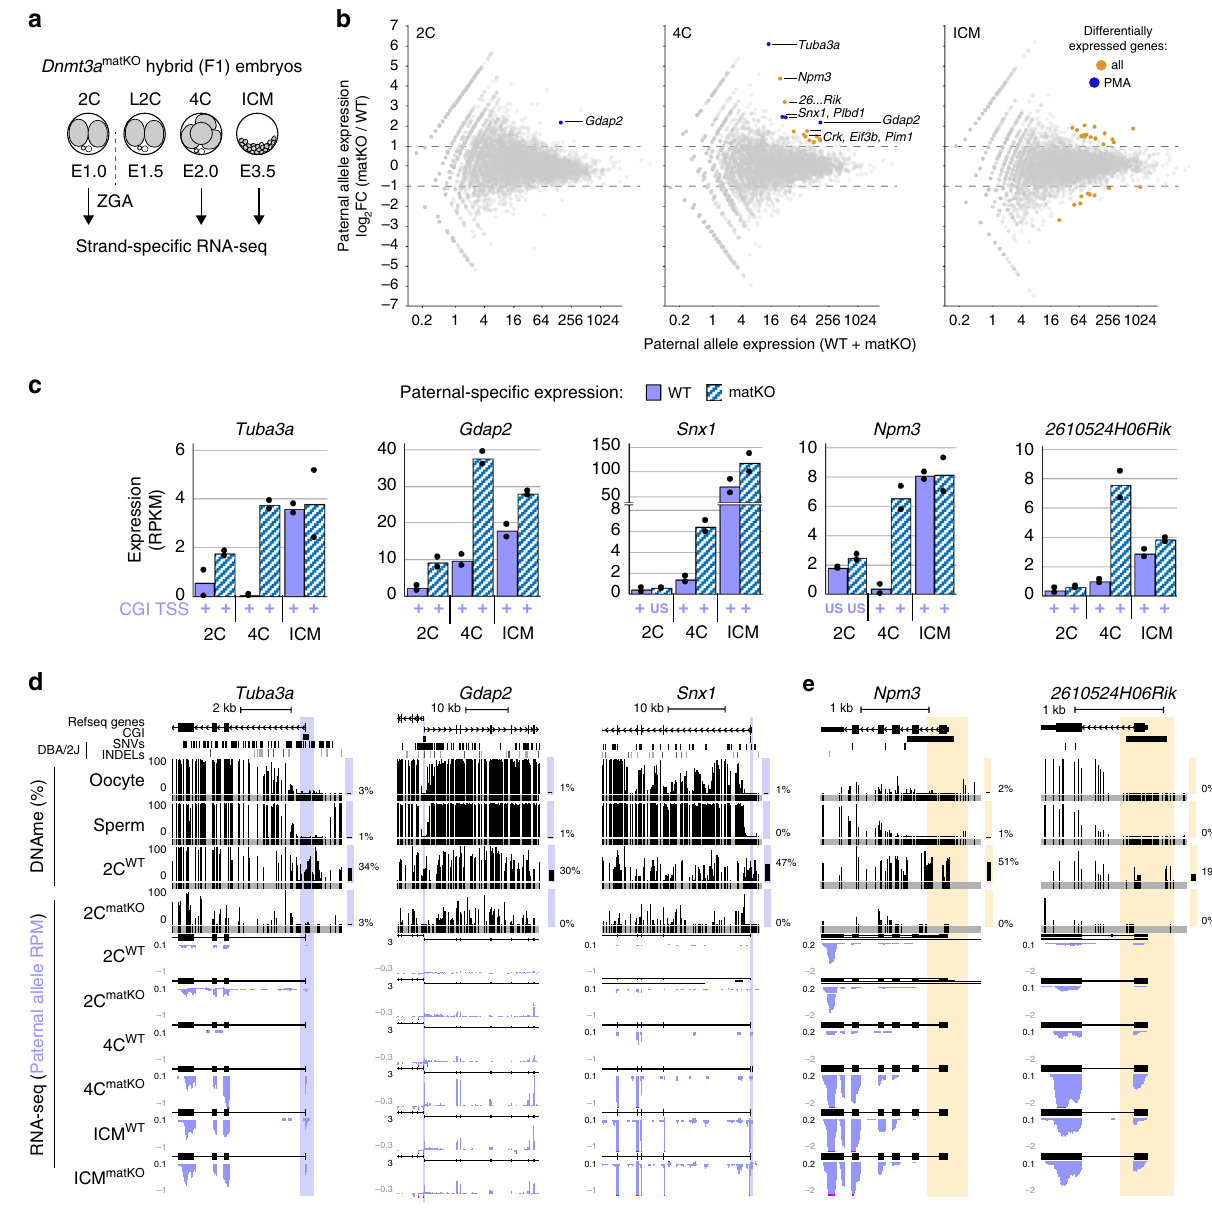
Fig. 5 Impact of maternal DNMT3A deletion on expression from the paternal allele. a RNA-seq libraries were generated in biological duplicates for wild- type and Dnmt3a matKO early F1 2C, 4C and ICM embryos. b Scatterplots showing average versus differential paternal-allele expression for 2C and 4C embryos as well as ICM cells. Genes showing a change in expression of ≥ 2-fold are highlighted in orange, and those that show PMA at their CGI promoters are highlighted in blue. c Bar graphs illustrating differential expression of select genes from the paternal genome in WT and matKO embryos. Each bar represents the mean expression value of two biological replicates (dots) in RPKM. Whether transcription of each gene initiates from the CGI promoter is indicated below each bar. US: upstream. d , e Screenshots of Tuba3a, Gdap2, Snx1, Npm3 and 2610524H06Rik , as presented in Fig. 1. RNA-seq data are represented as a composite track of biological replicates. De novo transcript assembly is shown above each RNAseq dataset. Total DNAme levels in adult gametes and 2C WT and Dnmt3a matKO embryos are included. Yellow highlights indicate the TSS ( + / − 300 bp) of genes that do not contain DBA/2J SNVs or INDELs and therefore could not be analyzed for allele-speci fi c DNAme state. Source data are provided as a Source Data fi